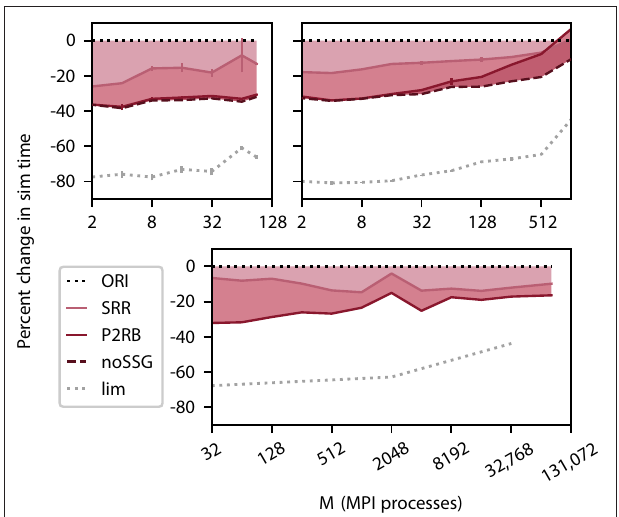
SRR+P2RB: Detailed reference algorithm delivering